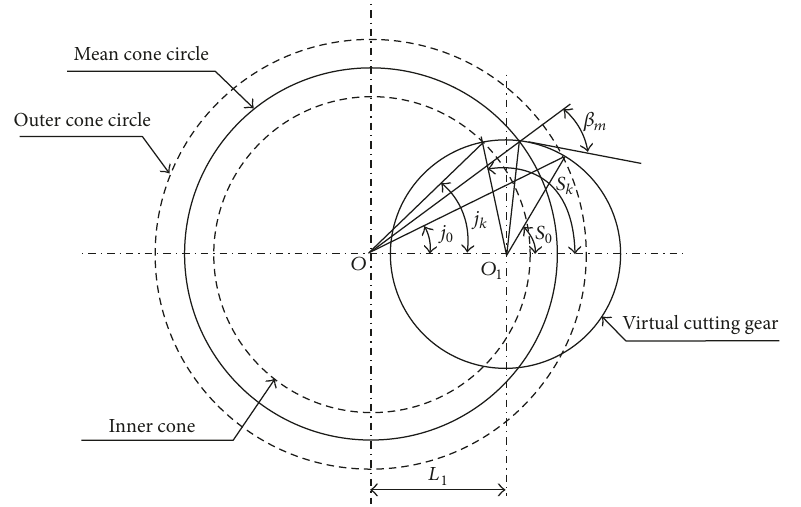
Figure 1: Pitch surface unfolded